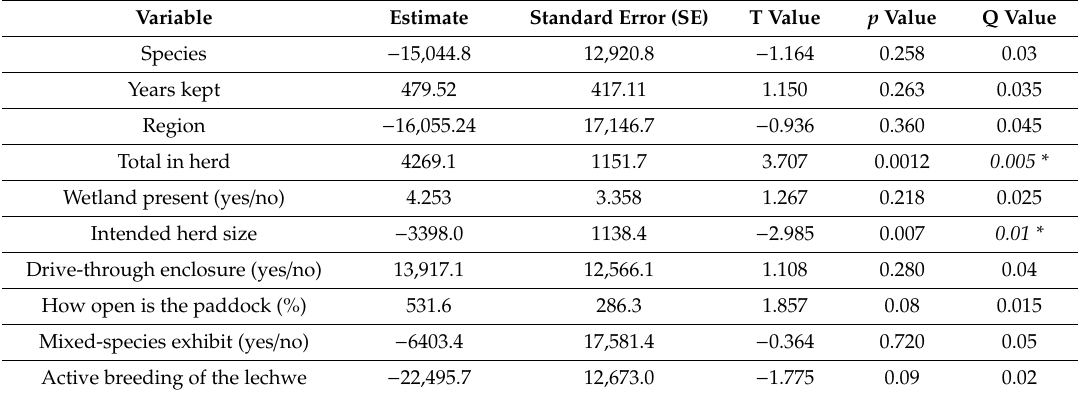
Table 4. Predictors of lechwe paddock size from responses provided to the